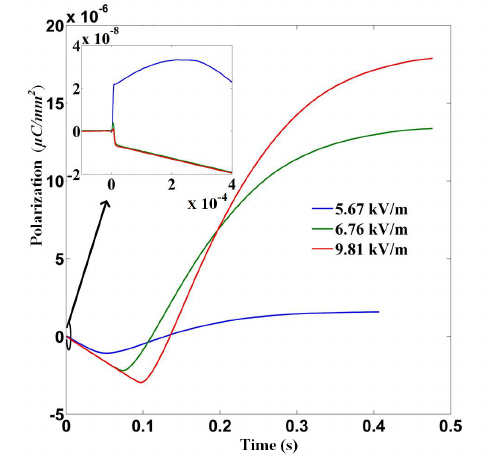
Figure 5. Surface polarisation at a function of time when the sample is excited by microwave fields of three distinct magnitudes. The pulse duration is kept at 2.2 µ